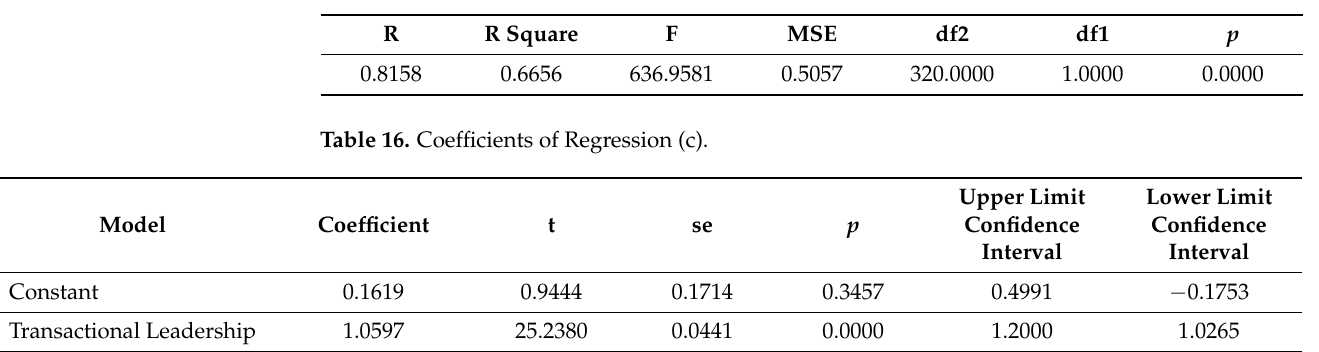
Table 15. Model Summary (c).